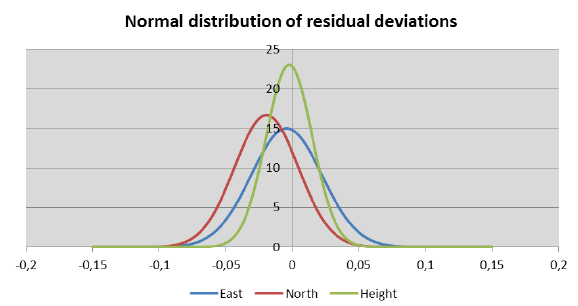
Figure 17. Normal distributions of coordinate deviations between points from TLS and photogrammetric models.